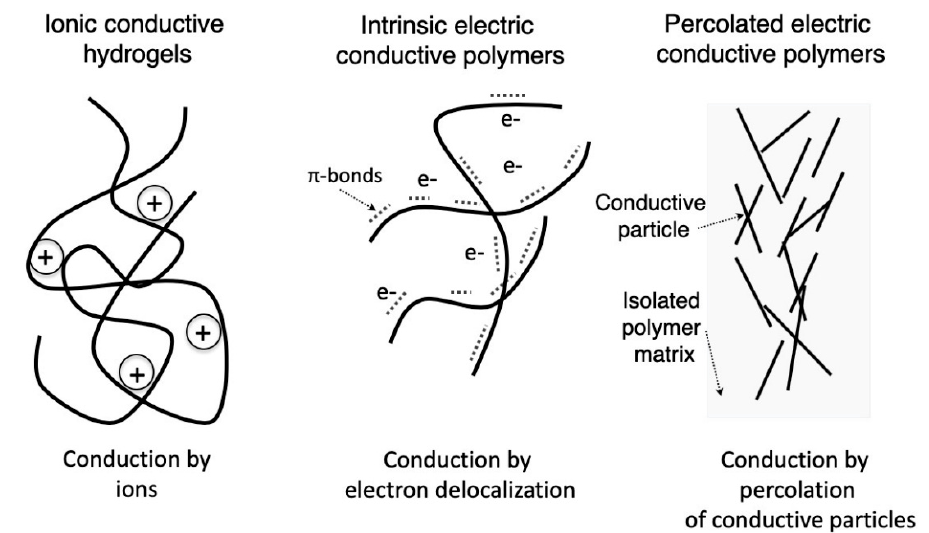
Figure 3. Simplified schematic diagrams showing the different conduction mechanisms of electroactive smart polymers. Ionic polymers present conductivities associated with the presence of polyelectrolytes (left side), while electric conductive polymers can transfer electrons by either an intrinsic mechanism associated with their chemical bonds (middle) or conductive particles percolated into the isolated matrix (right side). See text for details.